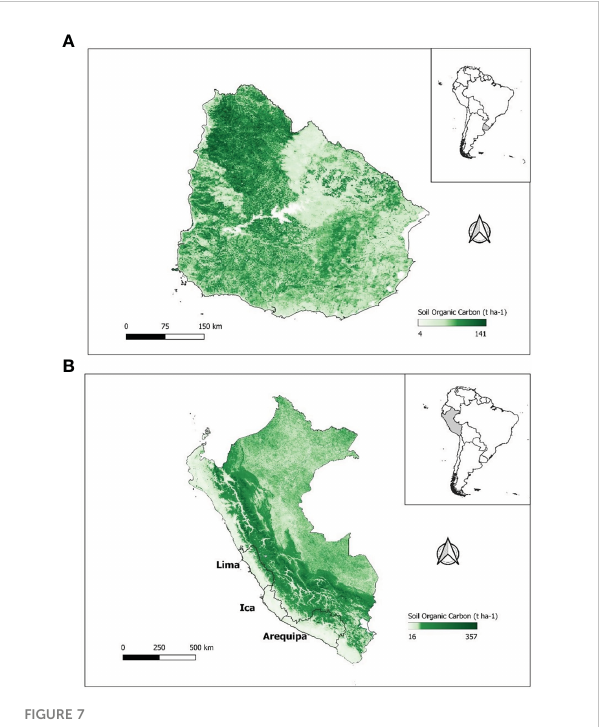
FIGURE 7 SOC in (A) Uruguay and (B) Peru. Source: own elaboration in QGis v. 3.26.2 (2022) based on the Global Soil Carbon Map